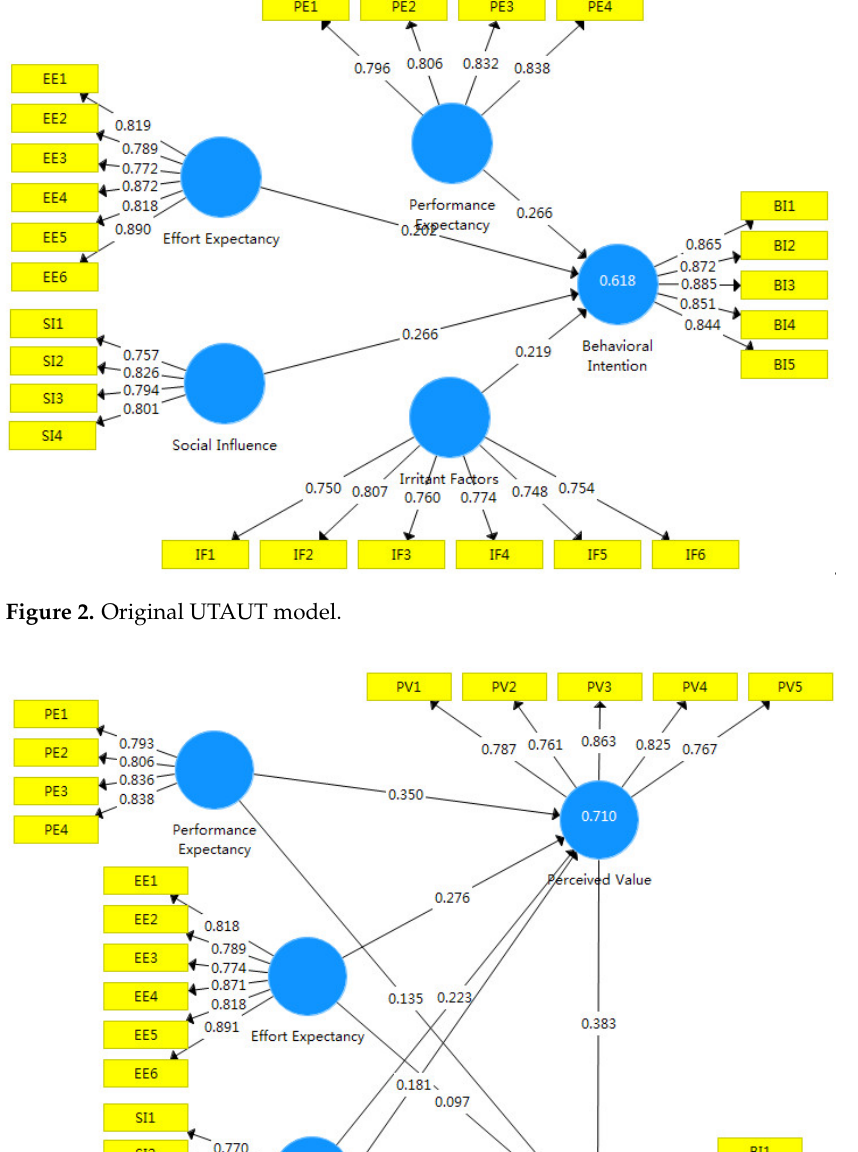
Figure 2. Original UTAUT model.